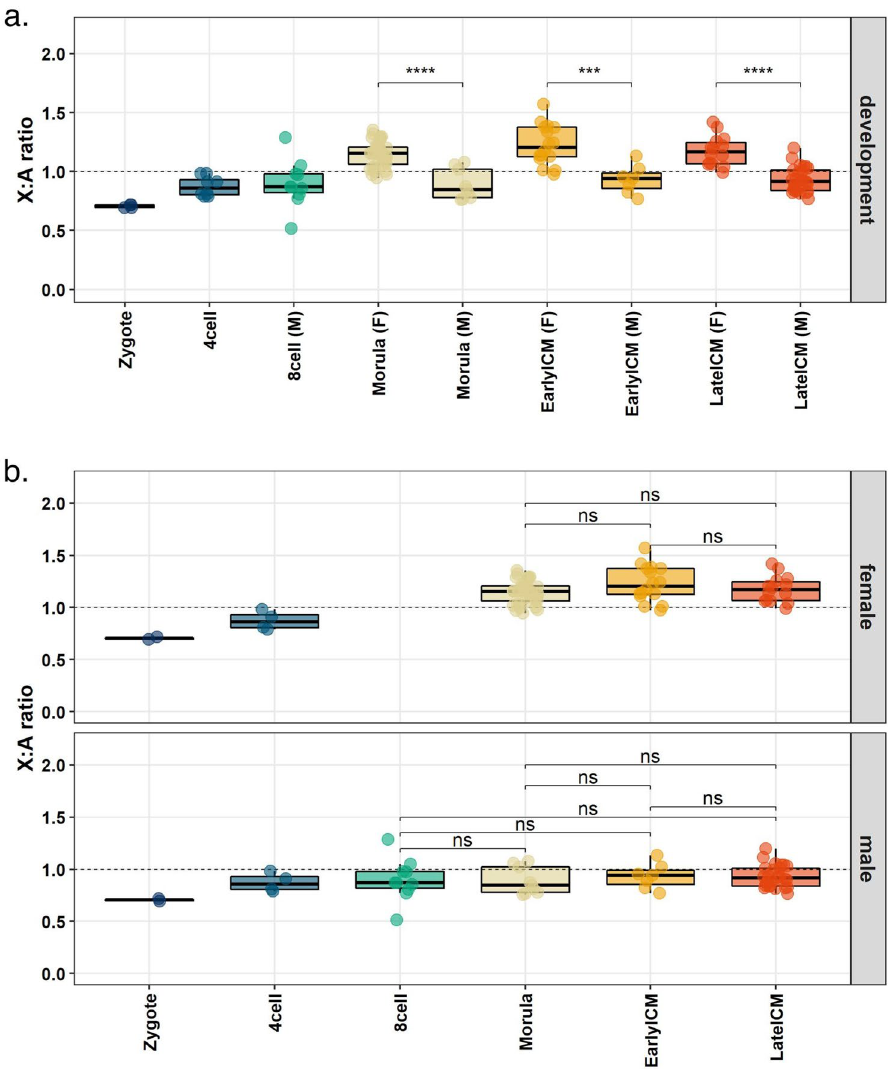
Figure 4. X-to-autosome dosage compensation. ( a ) X:A ratio distribution calculated per cell of each embryonic stage during marmoset preimplantation development. Unpaired Wilcoxon tests were used to compare males and females at the same developmental stage. (***) P-value ≤ 0.001; (****) P-value ≤ 0.0001. ( b ) Same as in ( a ) with one panel for each sex. Top panel: female embryos; bottom panel: male embryos. Note that, although not sexed, zygotes and 4-cell stage embryos are duplicated in order to maintain panels uniform. Unpaired Wilcoxon tests were used to compare different stages in males and females separately. (ns) not significant (P-value ≥